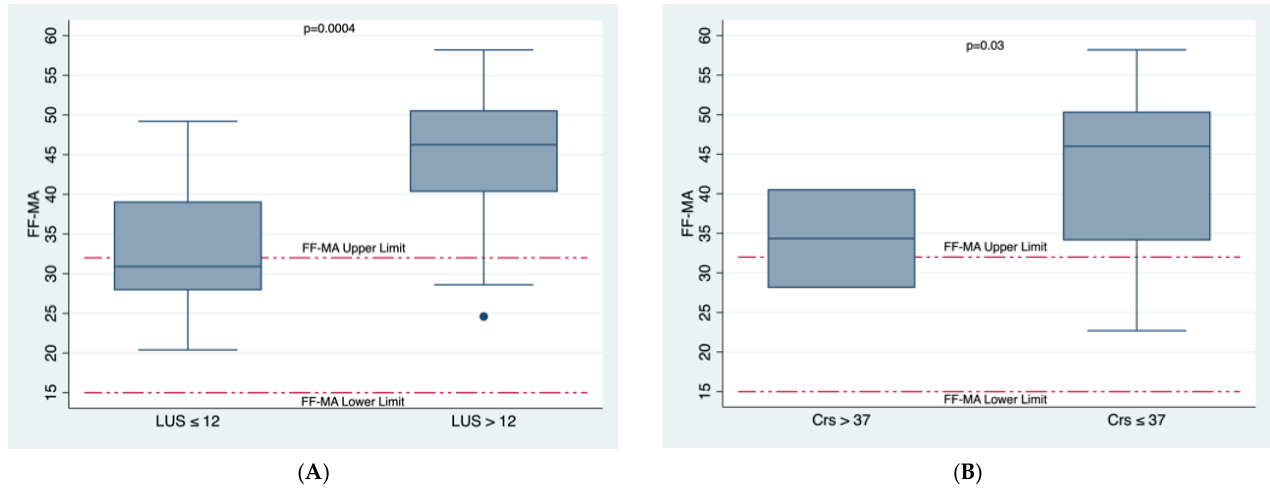
Figure 2. Figures showing FF-MA relationships with LUS score and Crs. ( A ). Significant and strong association between LUS score and FF-MA which is representative of the maximum amount of clot strength from fibrin, p = 0.0004. ( B ). There was also a significant but moderate association between Crs and FF-MA, p = 0.03.